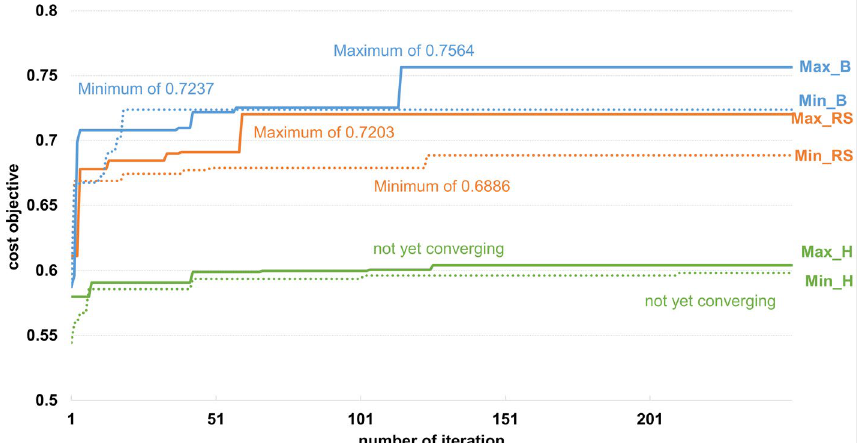
Fig. 5 Graph of cost objective against the number of iterations needed to converge to its